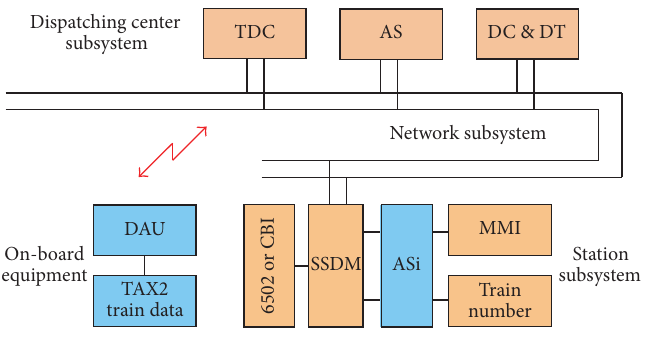
Figure 1: The structure of systems in CTC.